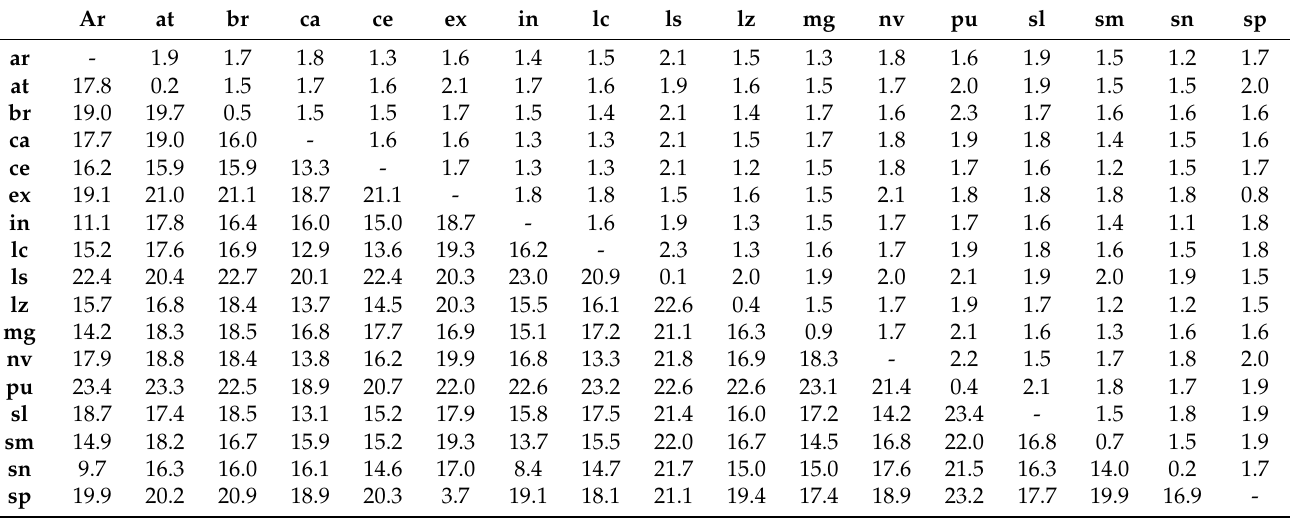
Table 1. Estimates of evolutionary divergence over sequence pairs between major clades of Daphnia using COI gene sequences. The number of base differences per site as averaged over all sequence pairs between the groups are shown below the diagonal. The number of base differences per site as averaged over all sequence pairs within each group are shown in the diagonal. Standard error (in bootstrap 100 replicates) estimates are shown above the diagonal. Codon positions included